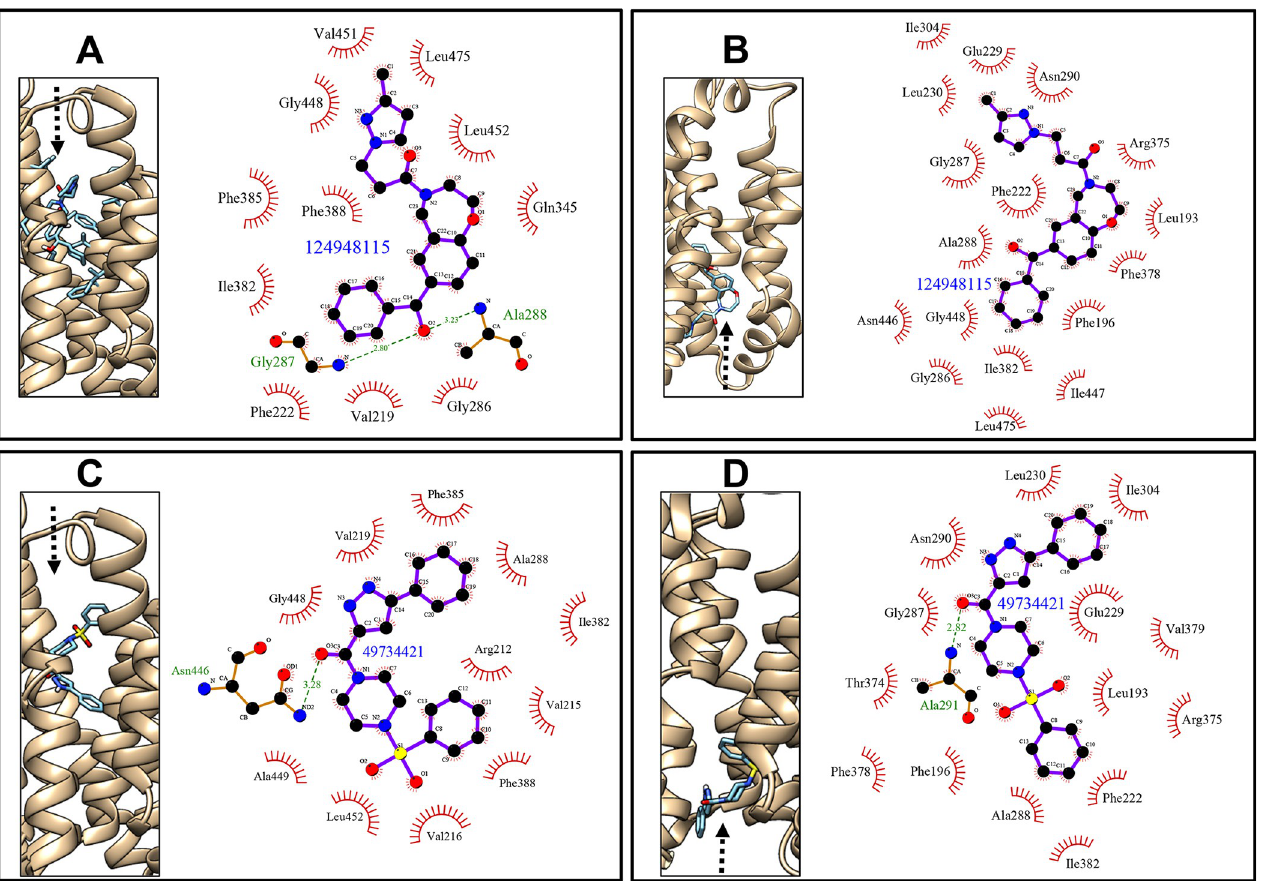
Fig 5. Docked pose of two compounds with IF-CsSBAT and OF-CsSBAT following the Lipinski’s rule of five. Binding modes of compounds were obtained from the MTiOpenScreen [52]. In each panel, left box ribbon and stick indicate a compound placed in the active site of OF-CsSBAT (A and C) and IF-CsSBAT (B and D). Right panel generated by LigPlot+ v1.4.3 [59] indicates the schematic interactions of CsSBAT with 124948115 (A and B) and 49734421 (C and D). The compound and residues with hydrophobic interactions are visualized with 2D diagrams. Amino acid residues involved in hydrophobic interactions are presented as red spoked arcs. Residues contributing to hydrogen bonds are depicted in green and atomic distance ( Å ) is given as green number. Nitrogen, oxygen, carbon, and sulfur atoms are shown in blue, red, black, and yellow, respectively. Black arrow indicates compound movement.